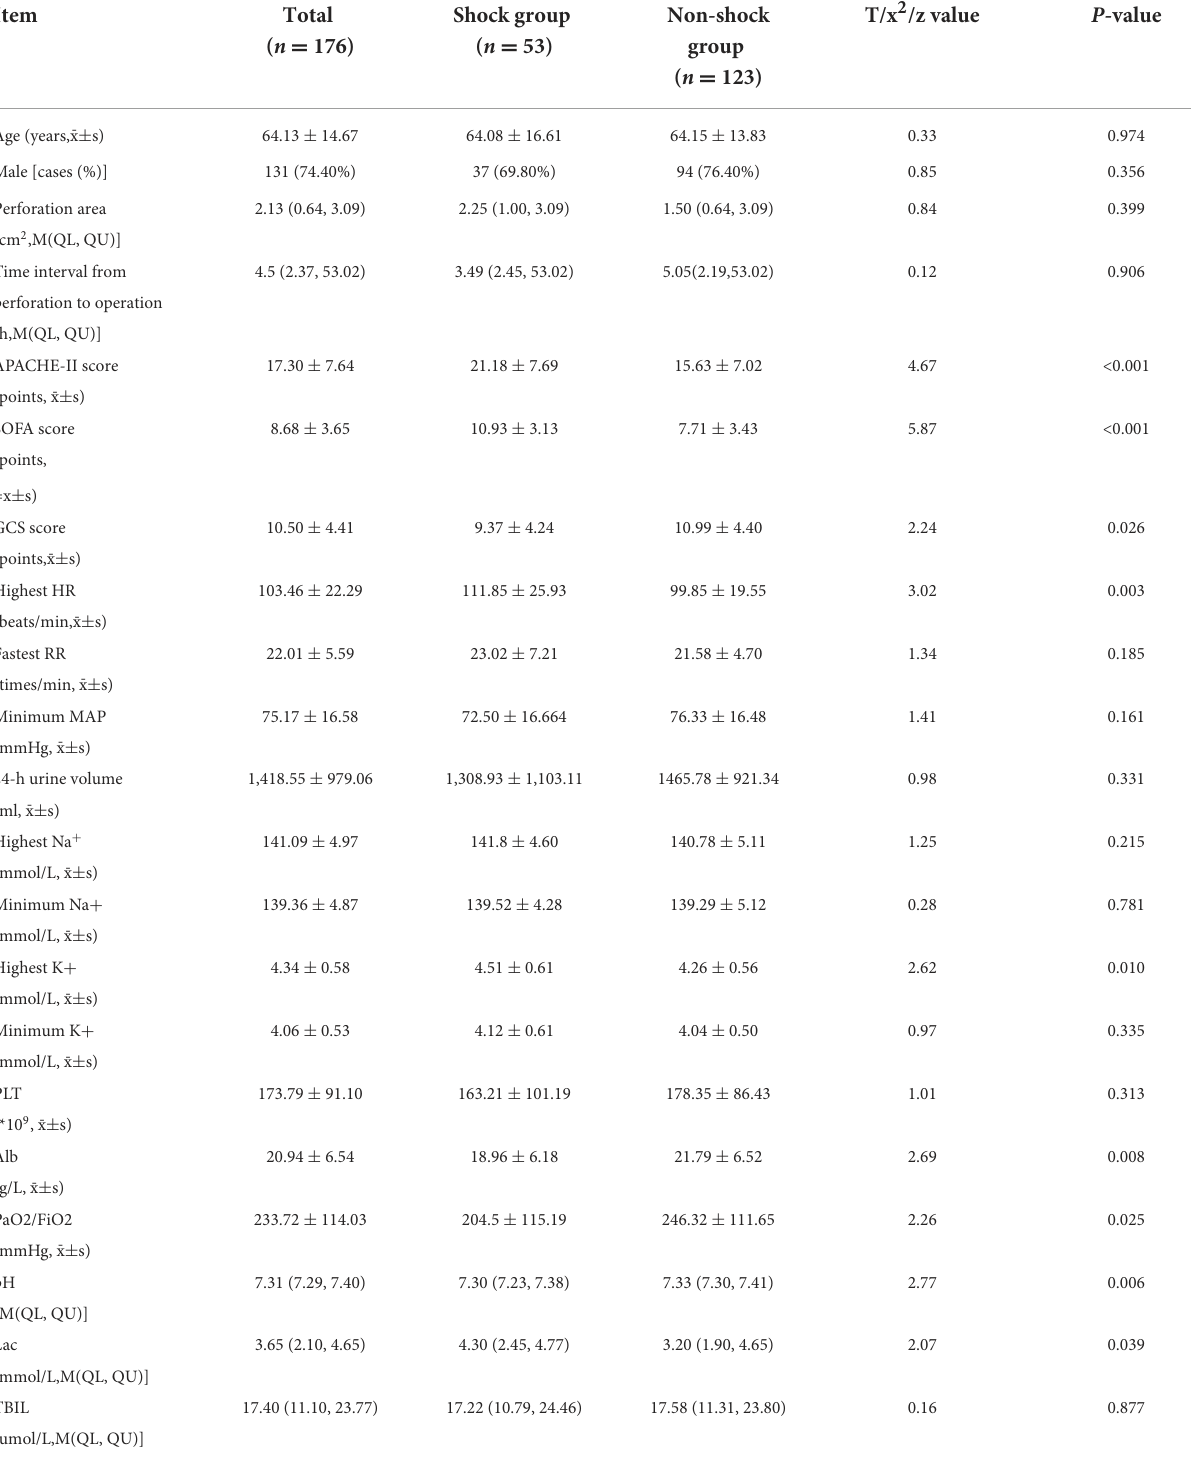
TABLE 1 Comparison of general data of the two groups of